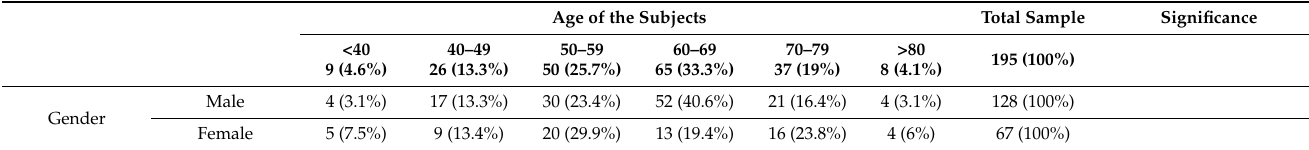
Figure 5. Distribution of DMFt < 13 according to age of the patients (in decades).